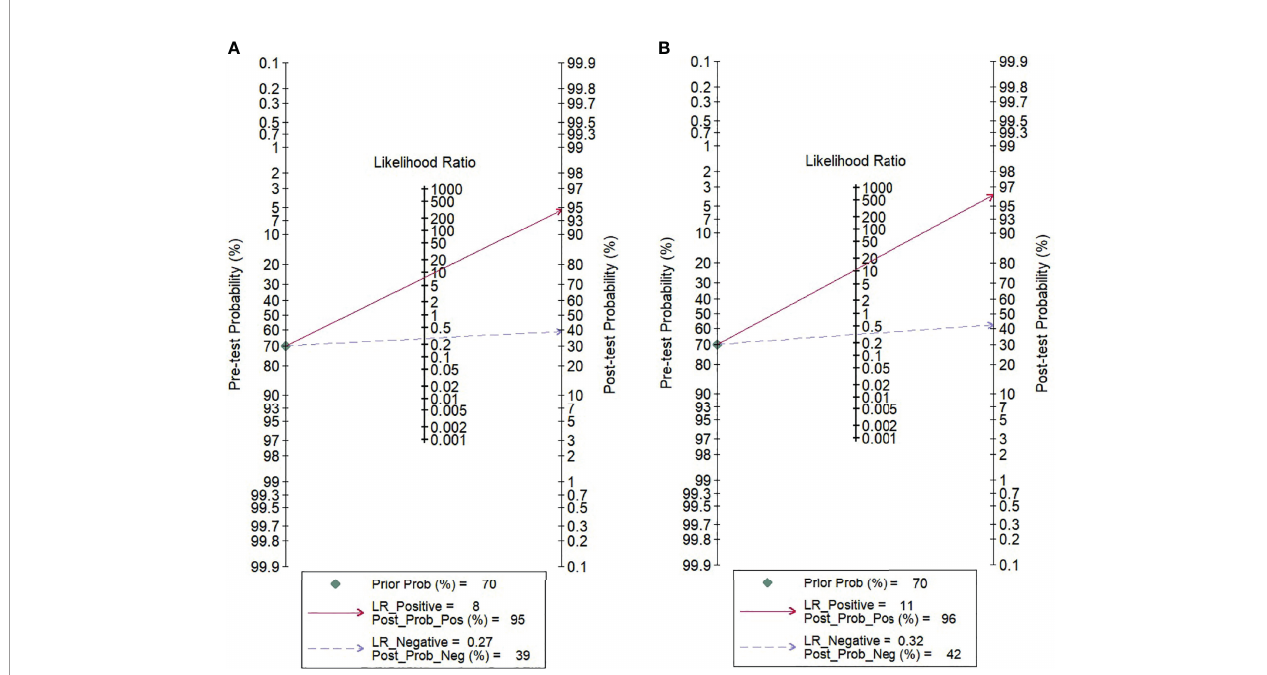
FIGURE 6 | Fagan ’ s nomogram evaluating the overall value of contrast-enhanced MRI for the diagnosis of HCC. (A) Gadoxetic acid-enhanced MRI. (B) ECA-MRI. HCC, hepatocellular carcinoma; ECA, extracellular contrast agent.